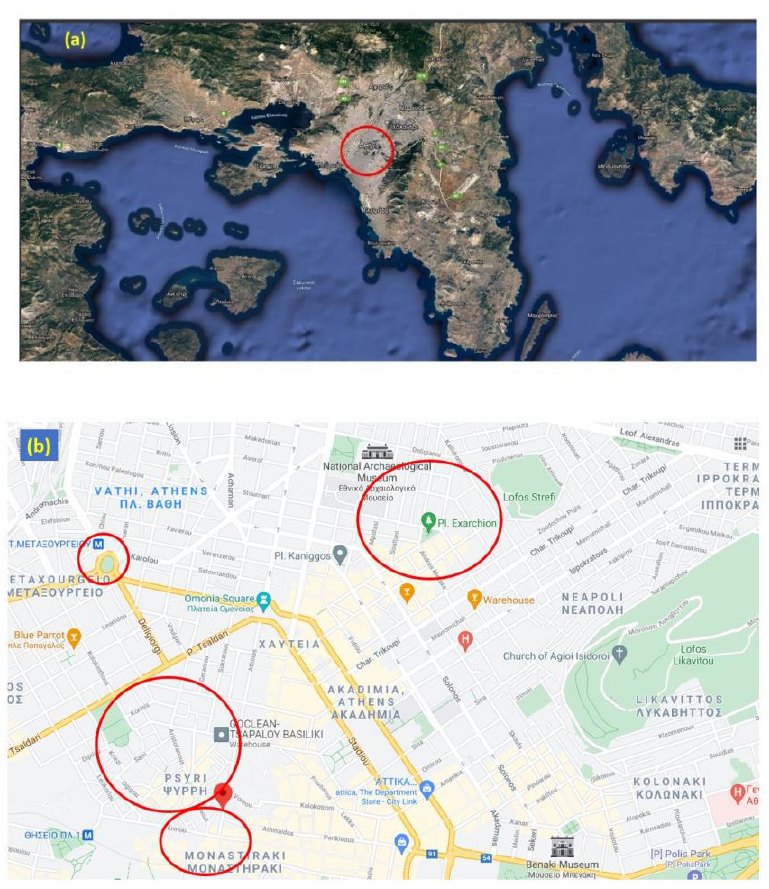
Figure 4. ( a ) Google Earth map of Attica. Central Athens is delineated by the red circle. ( b ) Google Map of the center of Athens where most of the near-collapse buildings studied are located. Larger and smaller circles indicate higher and lower concentration of near-collapse buildings.